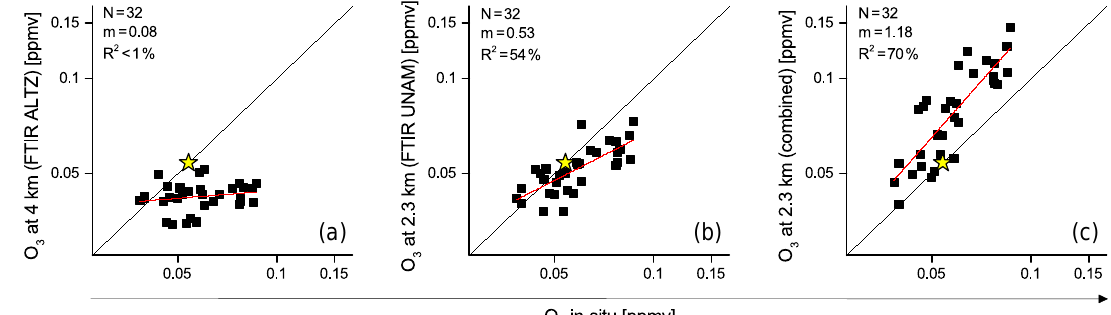
Figure 9. Correlation between O 3 volume mixing ratios measured by the in situ instruments for the boundary layer of Mexico City and the ratios obtained by the remote sensing experiments. The yellow stars represent the a priori values, the black lines are the one-to-one diagonals and the red lines are the fitted linear regression lines. (a) In situ O 3 versus O 3 obtained from the Altzomoni FTIR measurements for 4kma.s.l. (b) In situ O 3 versus O 3 obtained from the FTIR UNAM measurements for 2.3kma.s.l. (c) In situ O 3 versus the combined FTIR O 3 product for 2.3kma.s.l. (calculation according to Eq. 10).